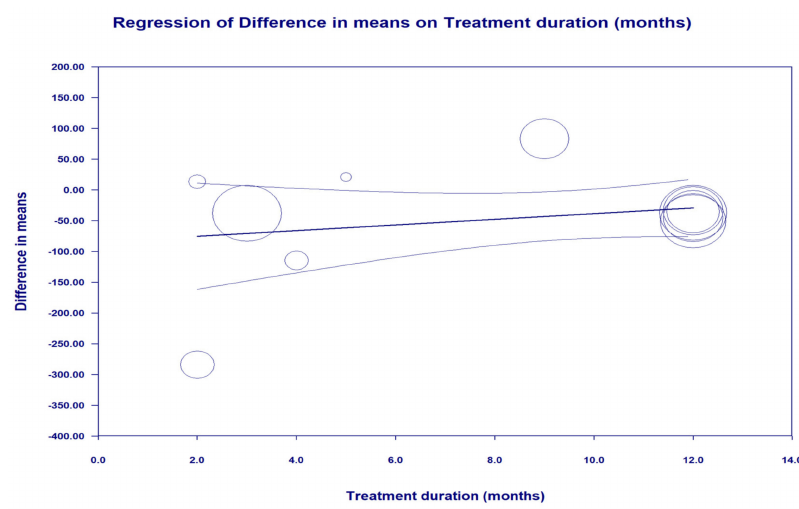
Figure 3. Random-effects meta-regression for evaluating the effect of treatment duration.